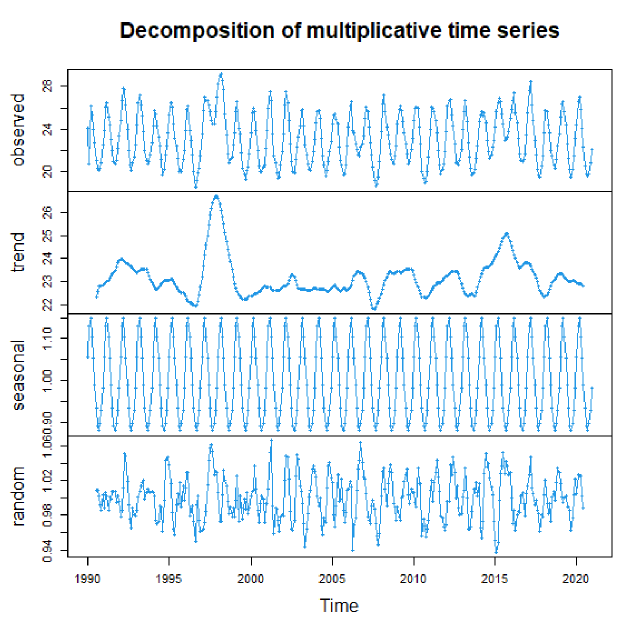
Figure 3. Monthly mean SST factor decomposition fitting comprehensive output